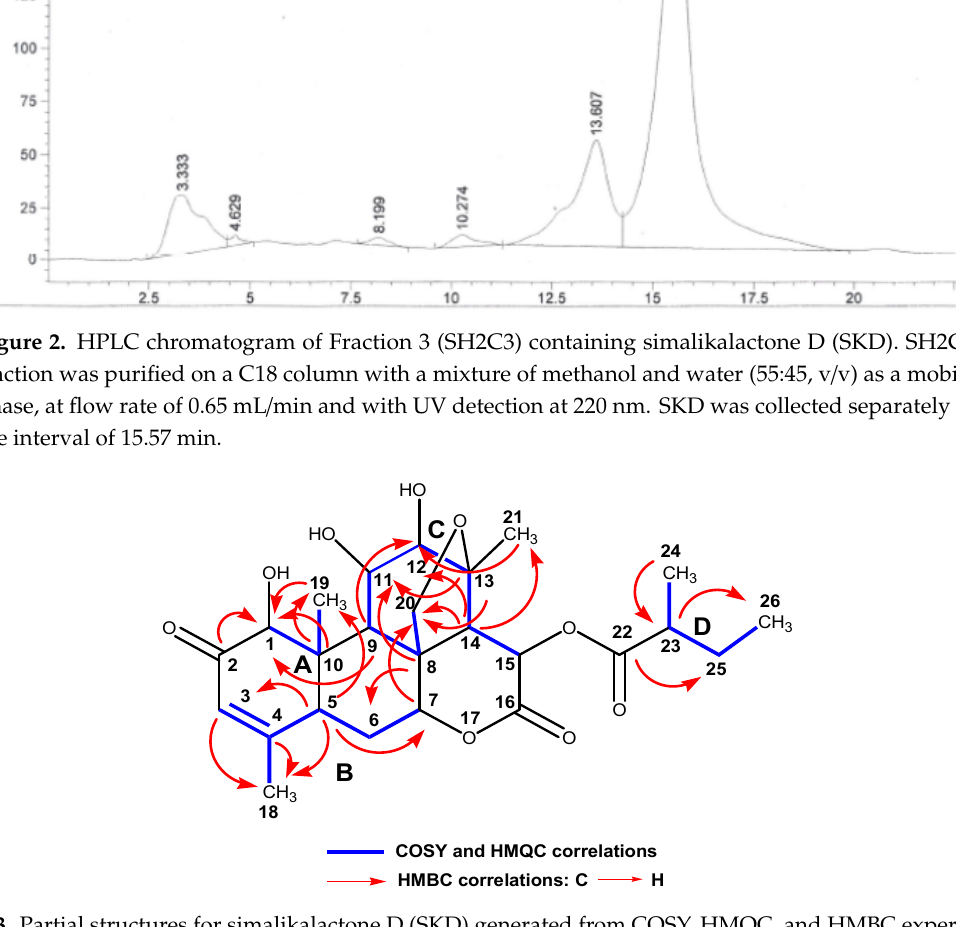
Figure 3. Partial structures for simalikalactone D (SKD) generated from COSY, HMQC, and HMBC experiments. Table 4. Selected 1 H NMR and 13 C NMR Spectral Data for Reported and Revised Simalikalactone D (SKD), Simalikalactone E (SKE), and Orinocinolide. Atom